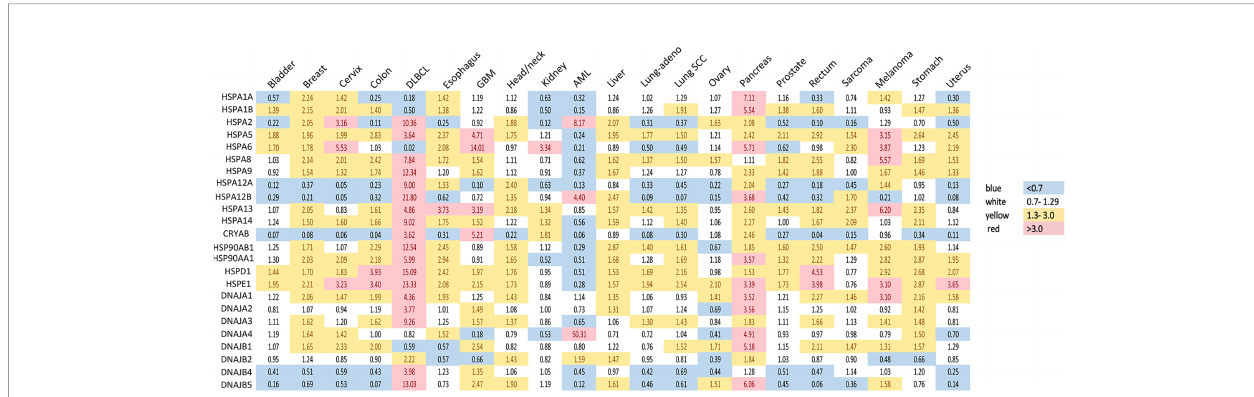
FIGURE 1 | Expression of heat shock genes across different types of human cancers. Shown are fold changes in gene expression of individual HSPs in cancers, which were calculated by dividing the number of transcripts per million in cancer tissue by that in the corresponding normal tissue. Transcript data were accessed through GEPIA (gepia.cancer-pku.cn) (25). Cancer types analyzed: bladder urothelial carcinoma, breast carcinoma, cervical squamous cell carcinoma and endocervical adenocarcinoma, colon adenocarcinoma, diffuse large B-cell lymphoma (DLBCL), esophageal carcinoma, glioblastoma multiforme (GBM), head and